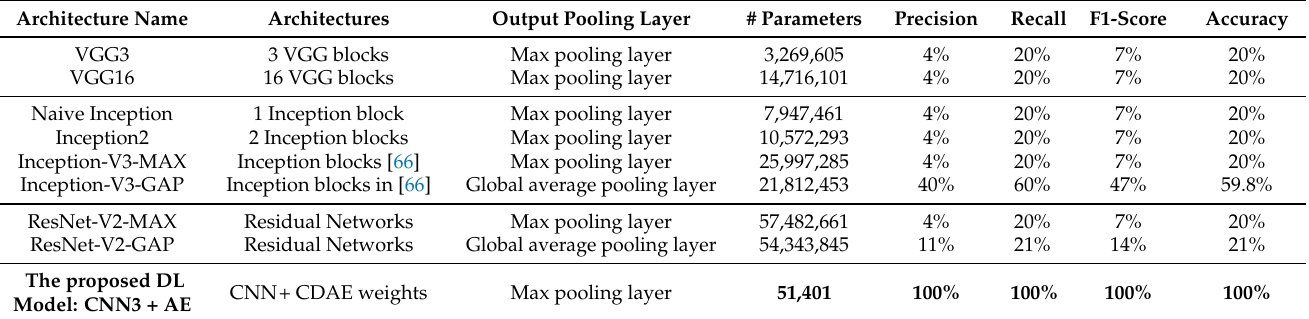
Table 3. Comparison to Benchmark DL Models using dataset of SNR 20 dB with AWGN (scenario 5). The highest performance number is highlighted. The lowest number of the model parameters is